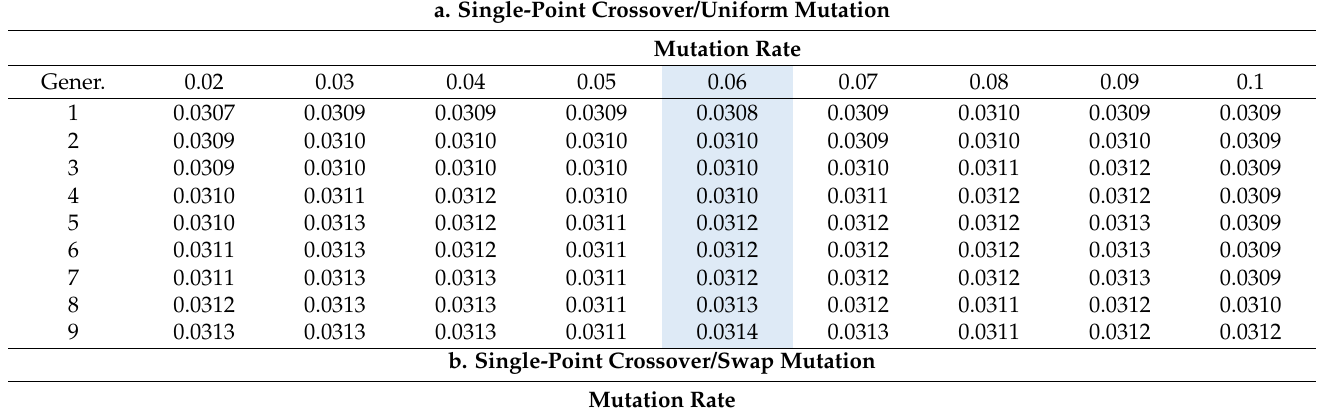
Table 4. The impact of mutation rate on the GA accuracy. The best results are highlighted. a. Single-Point Crossover/Uniform Mutation Mutation Rate